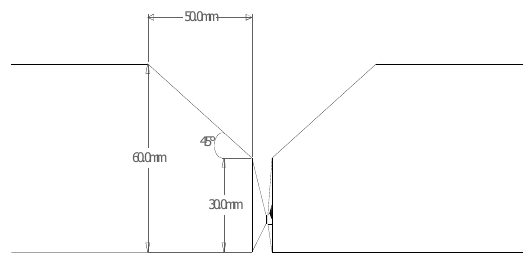
Figure 12. Side op view of seam position of CLHCPCS.